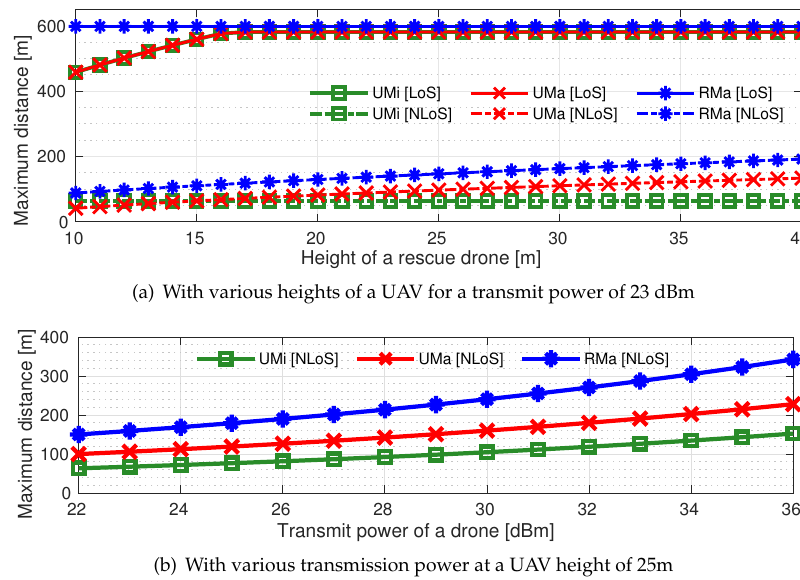
Figure 2. The maximum communication distance for various pathloss models.